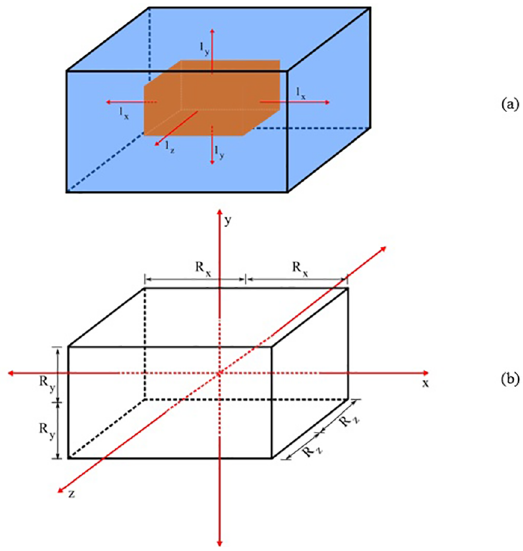
Figure 1. Scheme of the studied physical problem. a) fluid immersed composite and b) geometric dimensions of the